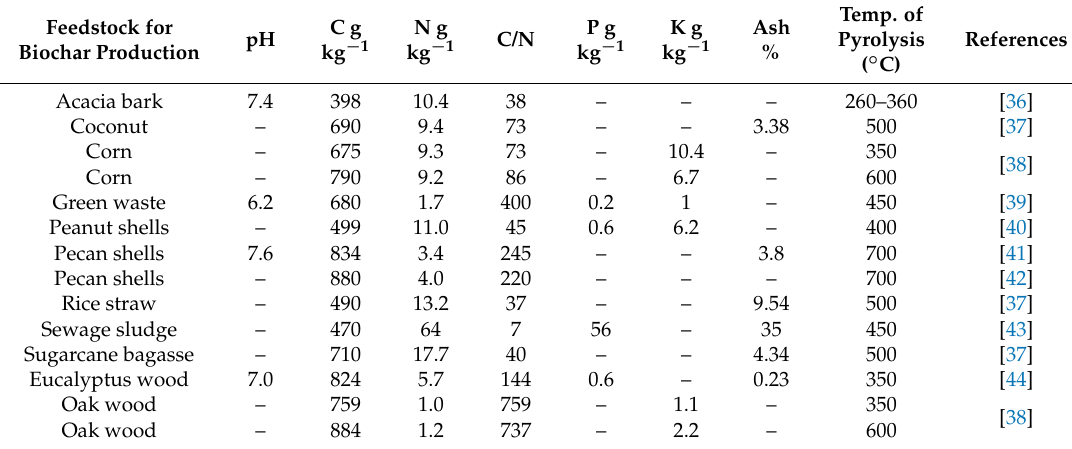
Table 2. Selected properties of biochar, depending on the materials applied and the temperature of the pyrolysis